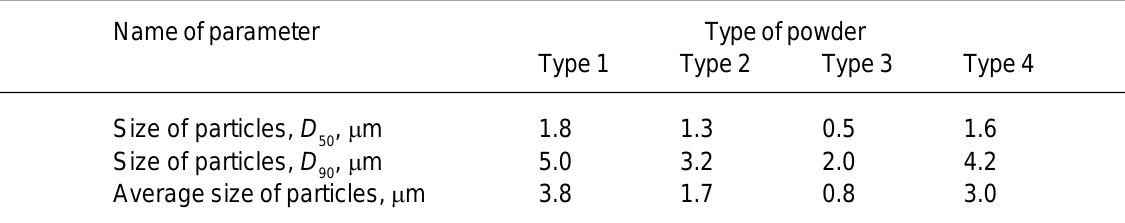
Table 1. Results of particle size analysis of corundum